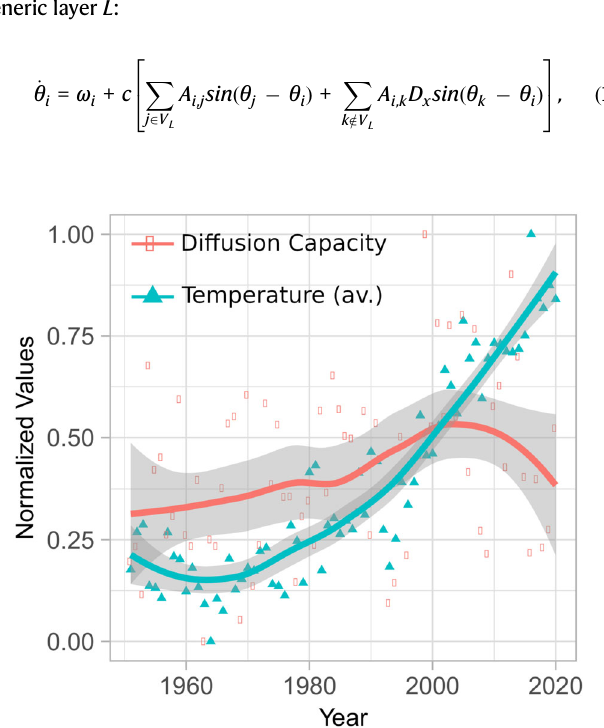
Fig. 2 | Comparison of Annual Diffusion Capacity and Temperature Values in Global Surface Air Temperature Climate Network. Annual values of diffusion Capacity (orange) and annualtemperaturevalues (green) for the global surface air temperature (SAT) climate